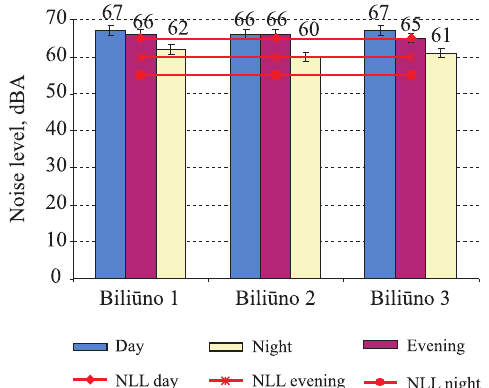
Fig. 4. Change of equivalent noise levels in J. Biliūno street in the course of a day (NLL – noise level limit)